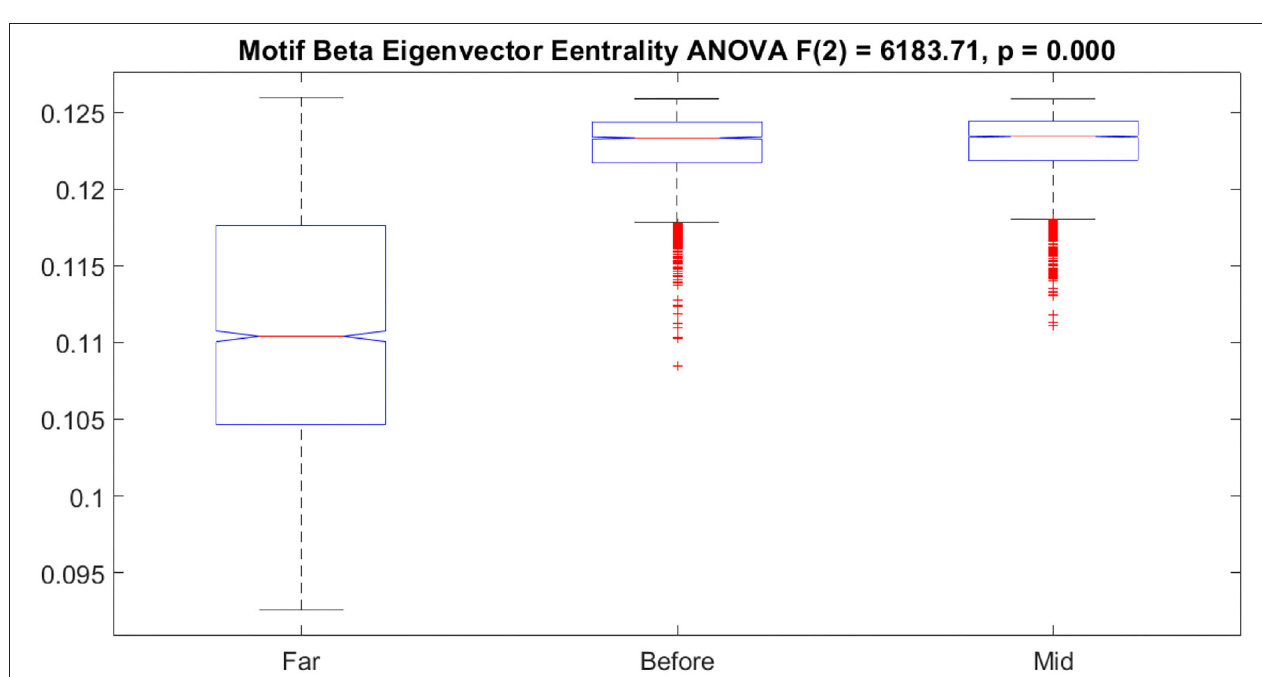
FIGURE 10 | Boxplot for global eigenvector centrality obtained with the motif method applied to the beta band and corresponding ANOVA result, comparing distributions obtained from far, before, and mid 1s EEG segments.